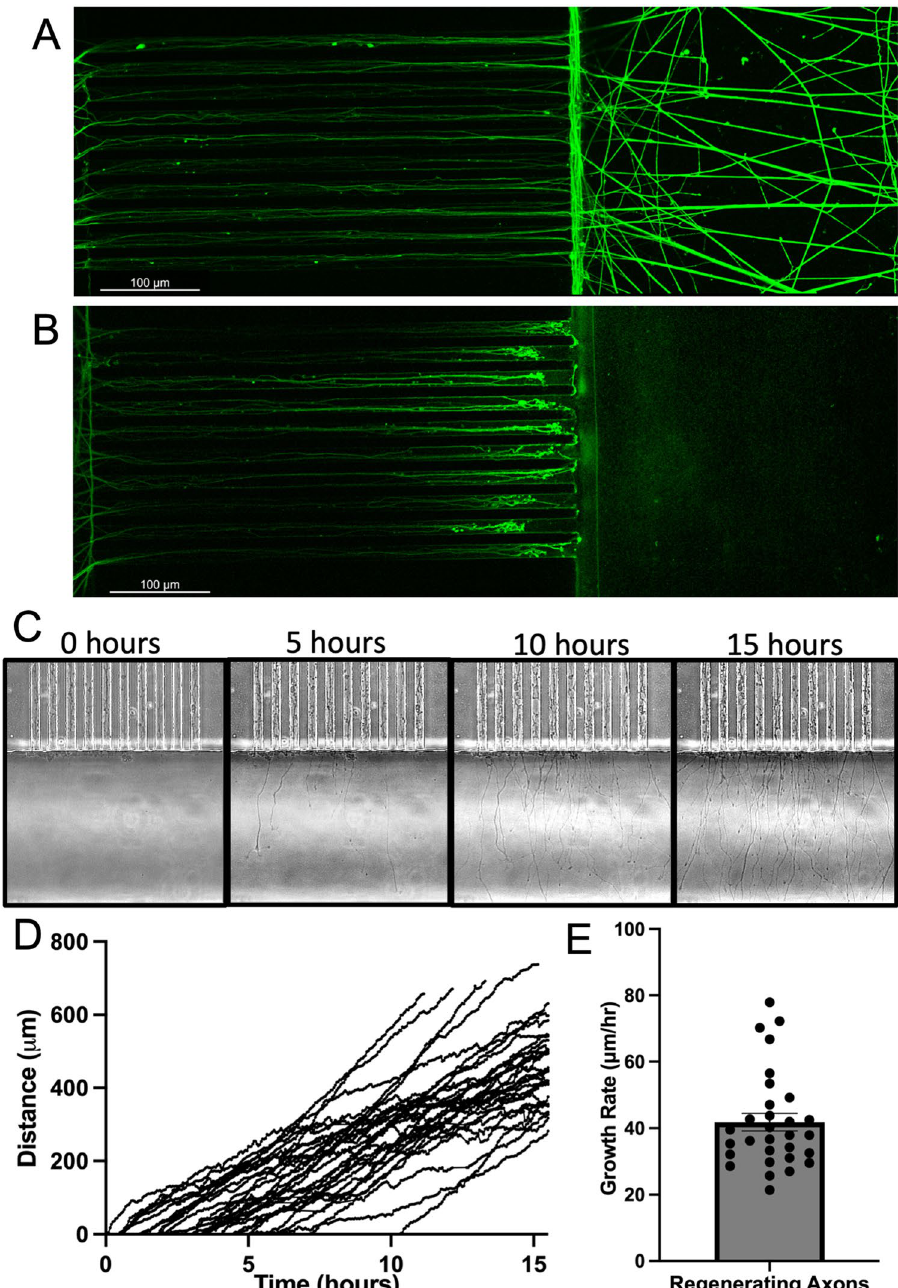
Figure 2. Axotomy and live-imaging of axonal regeneration of control hiPSC-MNs. ( A , B ) hiPSC-MN axons stained for smi-31 immediately following axotomy (hour 0). ( A ) Uncut hiPSC-MN axons in microchannels and axonal compartment. ( B ) Axotomized hiPSC-MN axons in microchannels Scale bar = 100 μm. ( C – E ) Immediately following axotomy, regenerating axons in the axonal compartment were imaged once every 3 min for 17 h to generate a time-lapse video from which axon terminals were tracked. ( C ) Representative individual frames from one set of microchannels following axotomy at the following fixed time points: 0 h, 5 h, 10 h, 15 h. ( D ) Regeneration distance of individual axons following axotomy. Each line represents an individual axon. n = 30. ( E ) Average regeneration speed. Each point represents the speed of an individual axon. n =